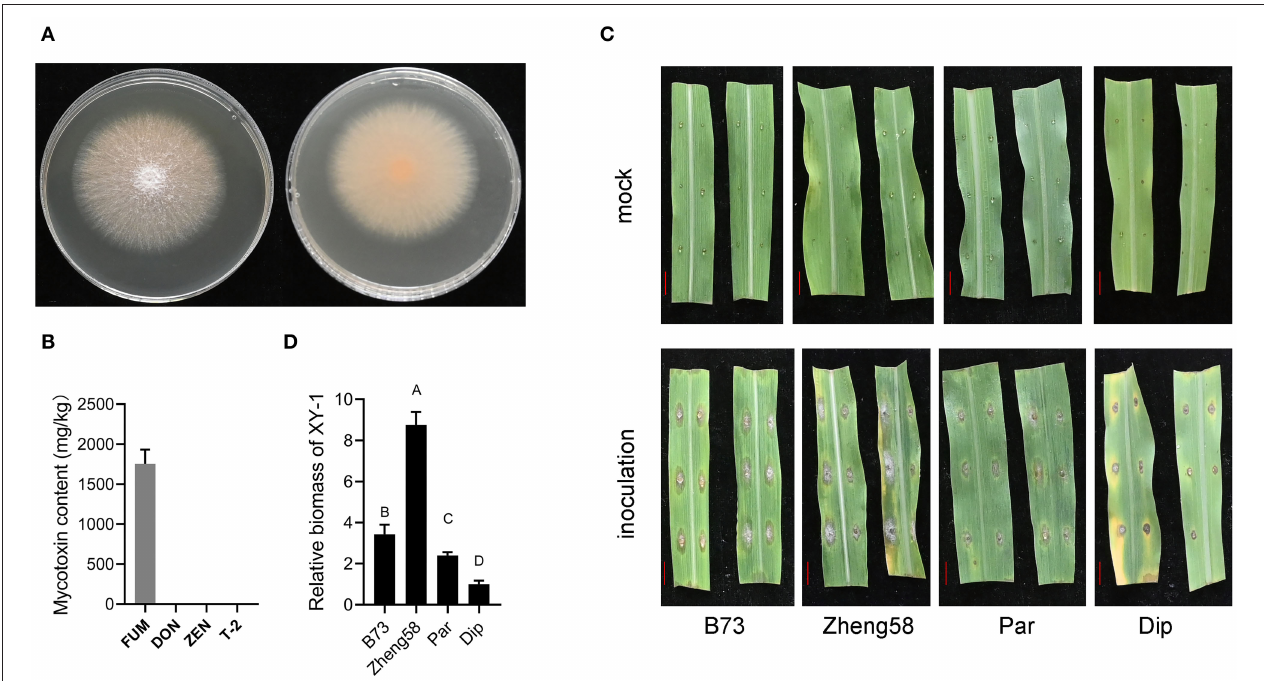
FIGURE 1 | The leaf resistance to F. verticillioides between modern maize and teosintes. (A) The front and back faces of F. verticillioides XY-1 grown on PDA solid medium for 5 days. (B) The contents of four mycotoxin produced by XY-1 grown in solid corn sand medium at 28 ◦ C in the dark for 5 days. FUM, fumonisins; DON, deoxynivalenol; ZEN, zearalenone. (C) Phenotype of detached leaves with and without XY-1 inoculation. The red bar represents 1cm length. (D) The relative biomass of XY-1 in inoculated leaves. Statistical analysis was performed using one-way ANOVA. Different letters on bar represent that the difference was significant at the level of p = 0.01. Dip, diploperennis ; Par, parviglumis .